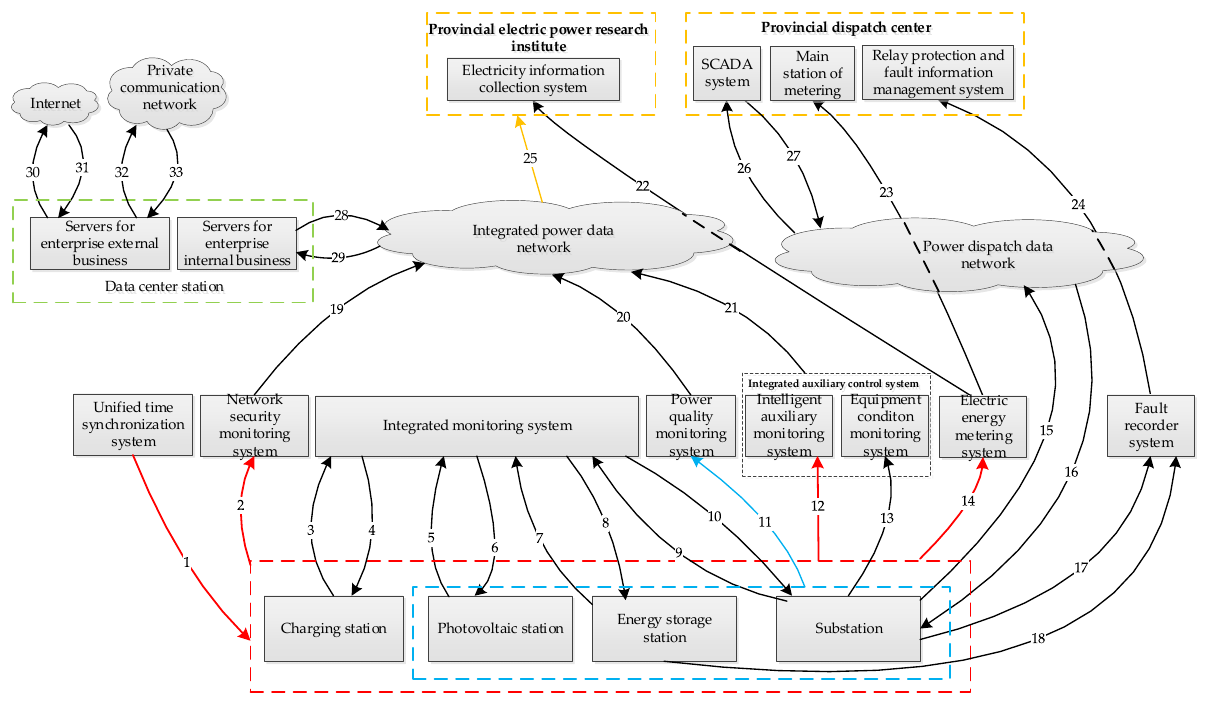
Figure 4. Data Exchanges of SESt.